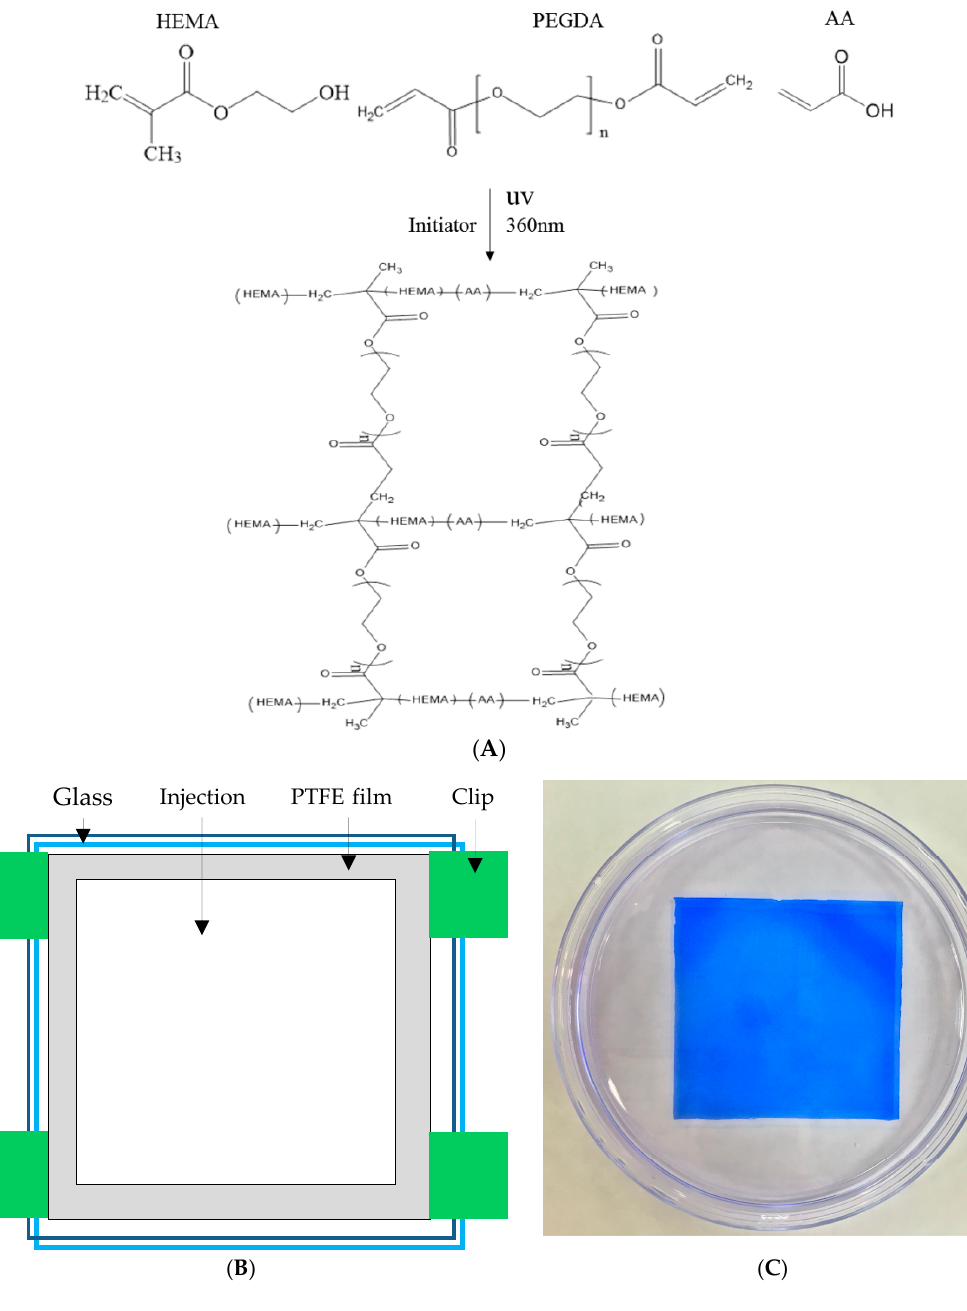
Figure 2. Fourier transform infrared spectroscopy (FTIR) analysis of HEMA, AA, PEGDA, and the hydrogel. Results of HEMA, AA, PEGDA, and the hydrogel are indicated in black, blue, red, and green, respectively.